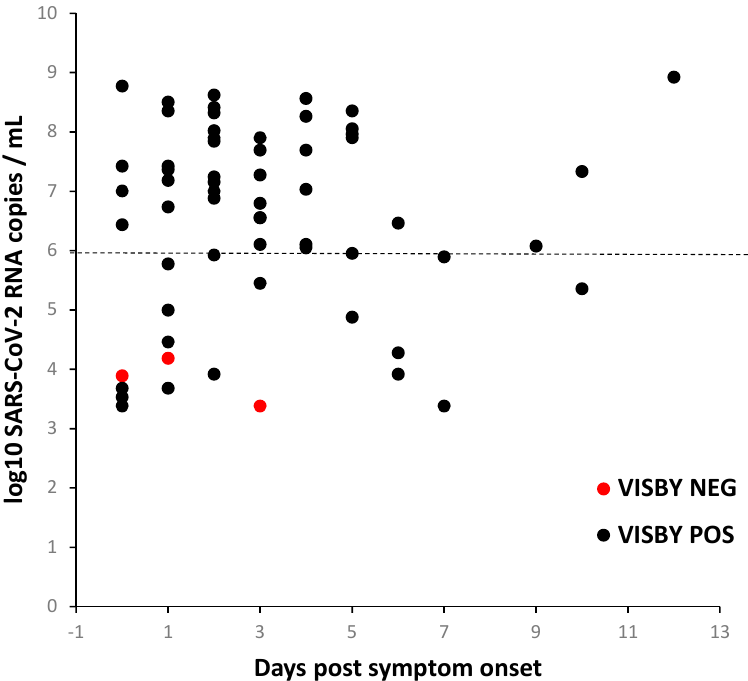
Figure 2. Detection of SARS-CoV-2 by Visby device based on viral loads and the time of symptom onset. SARS-CoV-2 viral loads by the time of symptom onset for the symptomatic and RT-qPCR positive individuals. Black and red dots represent positive or negative Visby results, respectively. Dotted line: 6 log 10 SARS-CoV-2 RNA copies/mL shows the VL threshold limit determining the number of culturable viruses. Note: Samples classified at day 0 include 4 samples with unknown dates of symptoms.